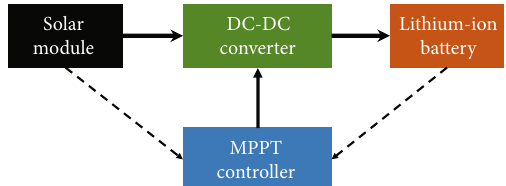
Figure 2: Block diagram of a basic SCC device.